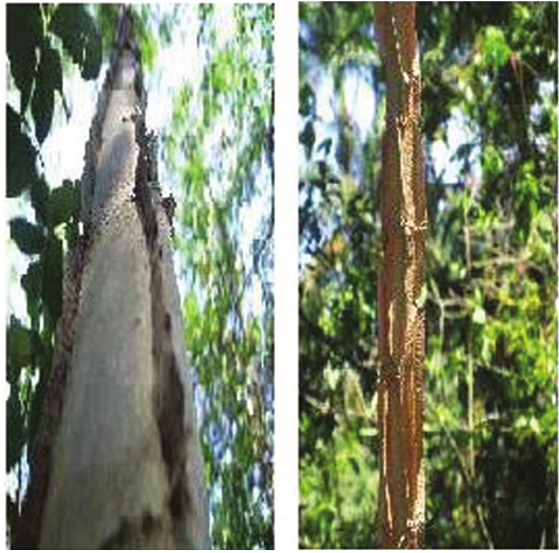
Fig. 1 – Stalk aspect of Piptadenia gonoacantha , “pau-jacaré”.